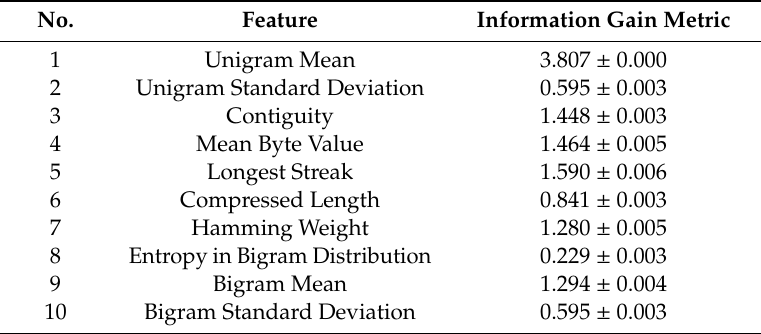
Table 1. Information gain for feature